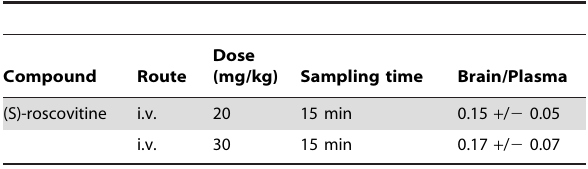
Table 2. Blood brain barrier (BBB) permeability of injectable